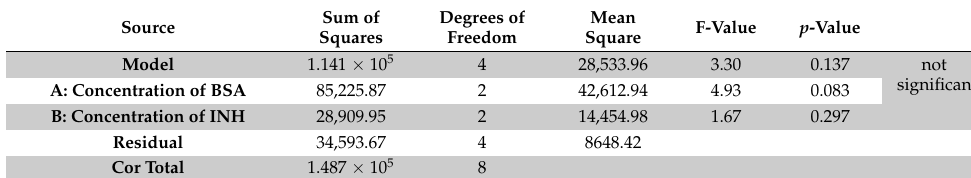
Table 6. ANOVA table for the NPs